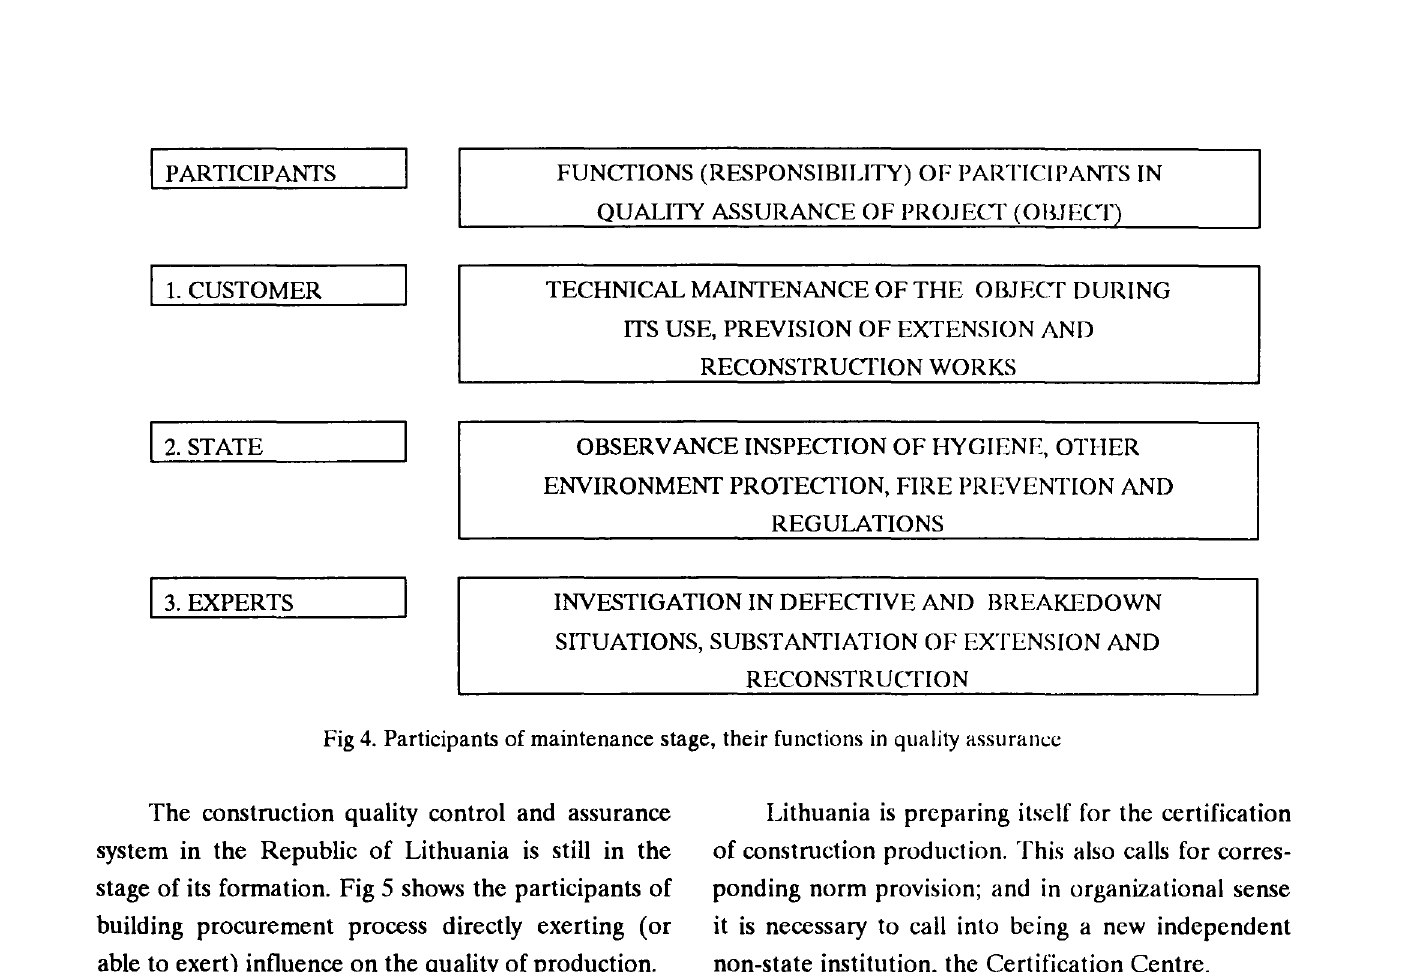
Fig 4. Participants of maintenance stage, their functions in quality